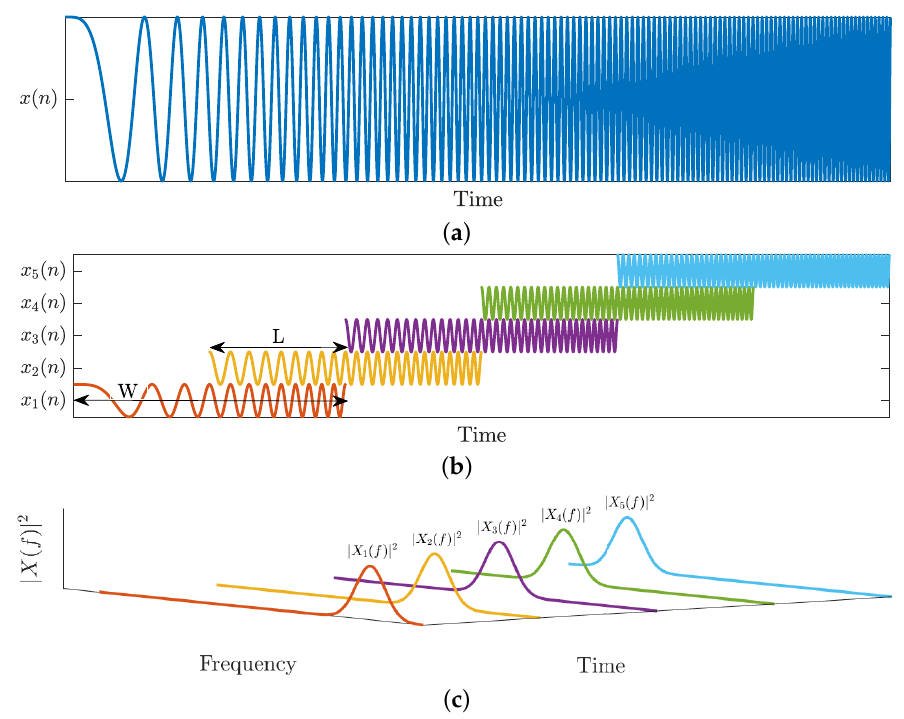
Figure 2. Short-time Fourier transform (STFT) calculation: ( a ) chirp signal; ( b ) signal distribution for overlapping windows; ( c ) DFT of each windowed segment.